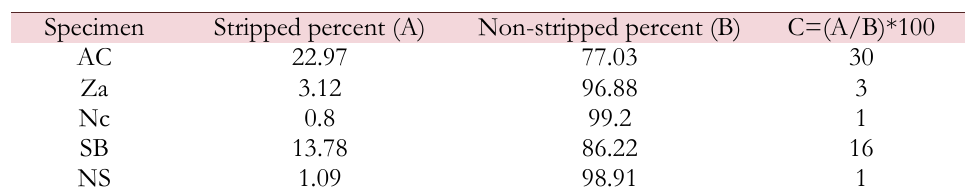
Table 5: MATLAB output for SEM specimens